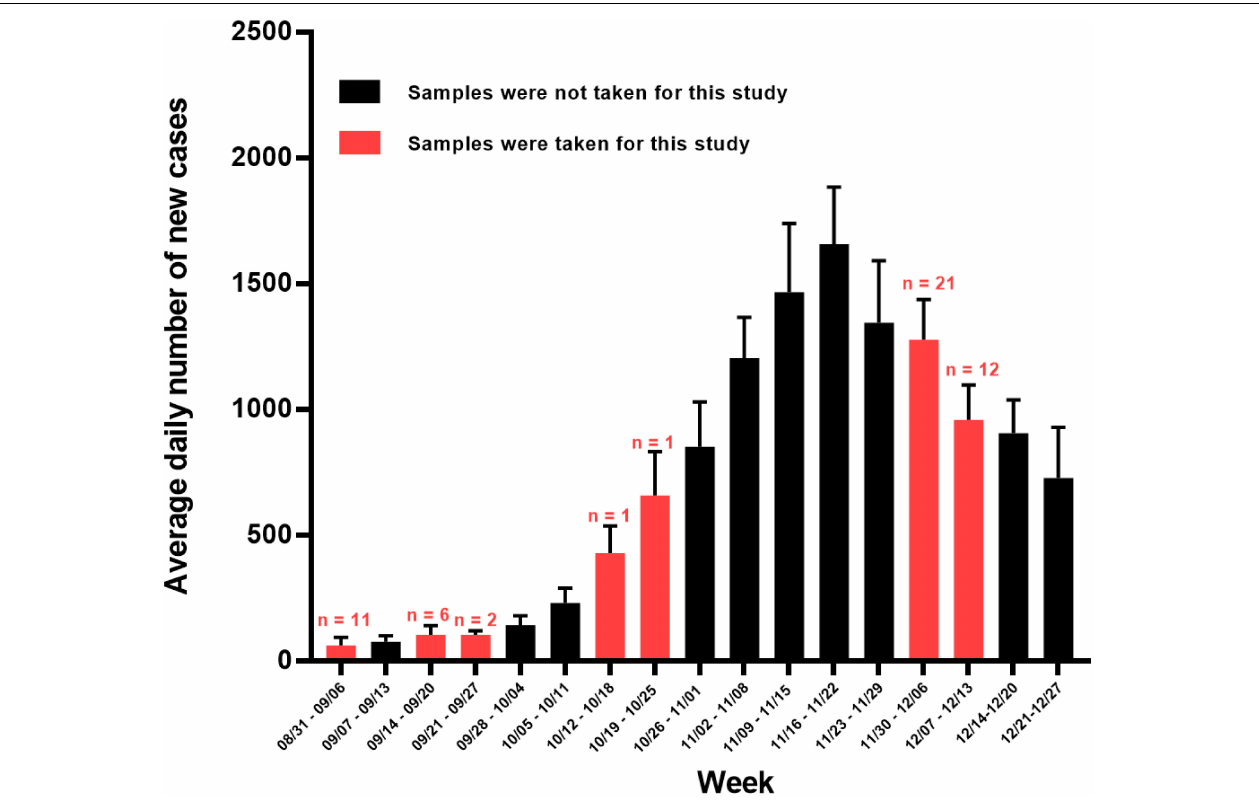
FIGURE 1 | Average daily number of new SARS-CoV-2 positive cases per week in Sicily between 31 August 2020 and 27 December 2021. Red bars denote weeks in which samples were taken for this study (number of samples taken shown above red bars) whereas non-sampled weeks are colored black. Error lines show SDs. Data for Sicily were downloaded from the GitHub repository (https://github.com/pcm-dpc/COVID-19/tree/master/dati-regioni). TABLE 2 | Primer pairs used in PCR amplifications to detect SARS-CoV-2 variants after partial sequencing, as detailed in the corresponding columns. PCR